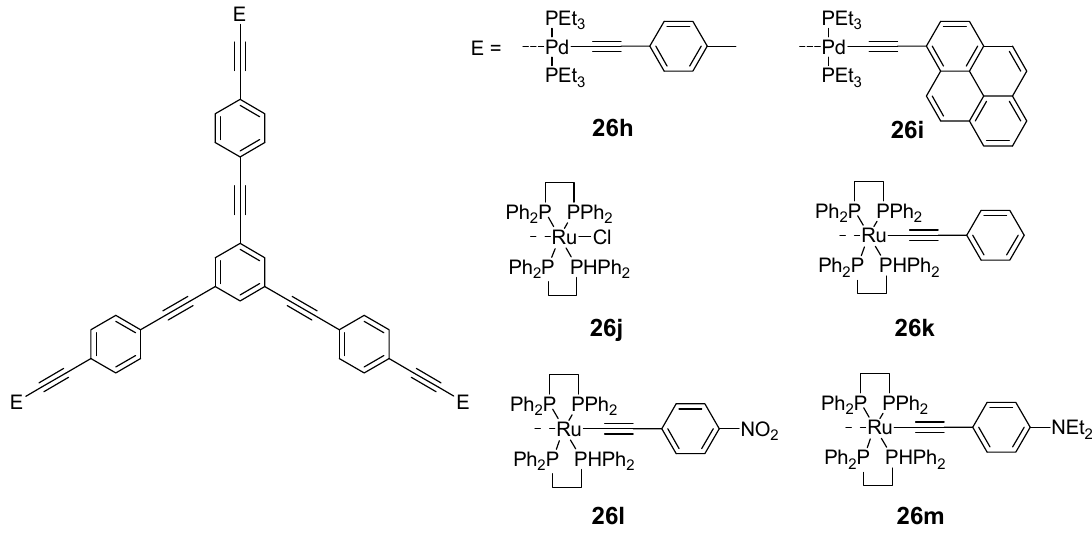
Figure 15. Complex star-shaped supramolecules with a OPE center of Yam et al . ( 26h , 26i ) and Humphrey et al . ( 26j-m ) showing tunable phosphorescence and non linear